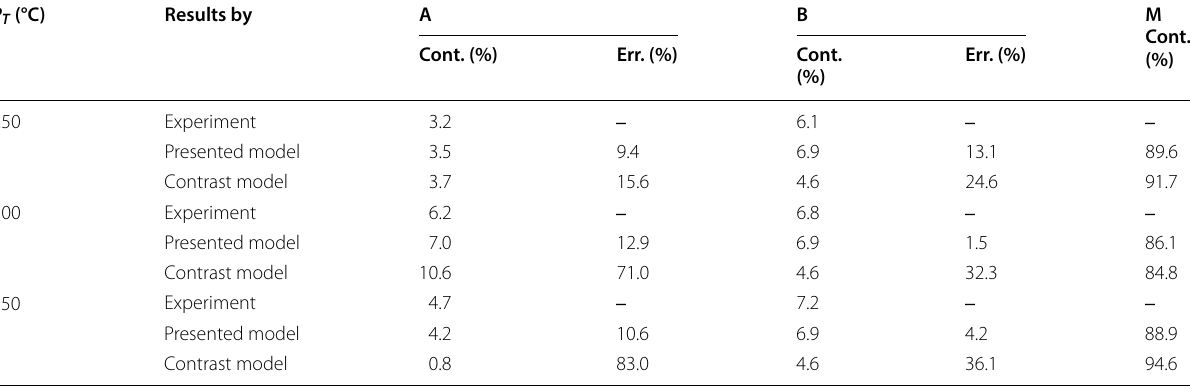
Table 3 Comparisons of phase contents prediction results with experimental values P T (°C) Results